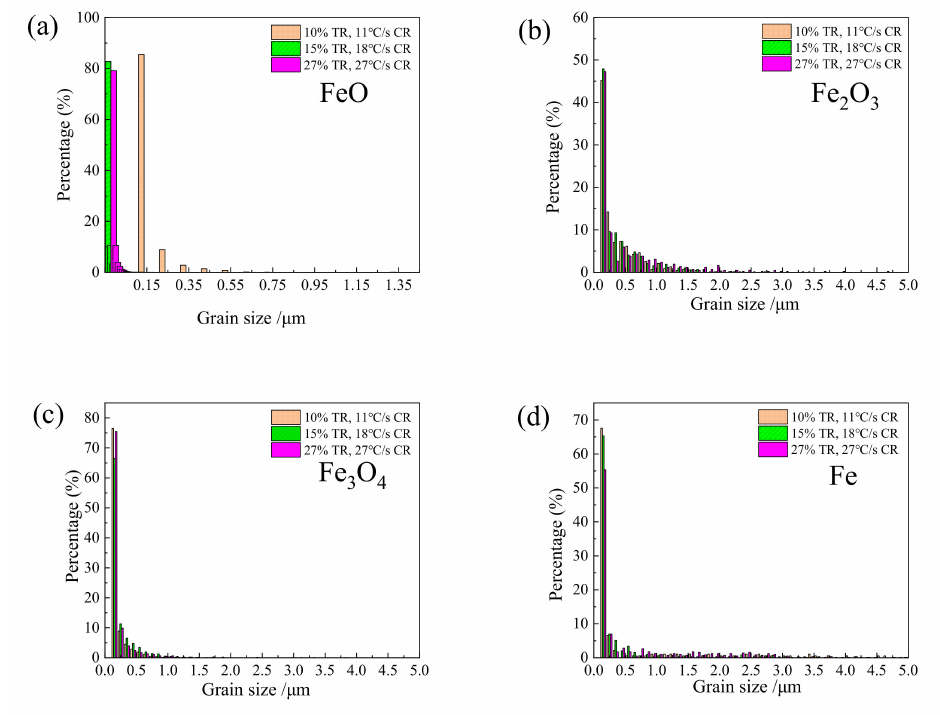
Figure 8. Histogram of oxide phase grain size distribution for ( a ) FeO, ( b )Fe2O3, ( c ) Fe3O4, ( d ) Fe and the steel with the thickness reduction of 10%, 15%, and 27%, and a cooling rate of 11, 18, 27 ◦